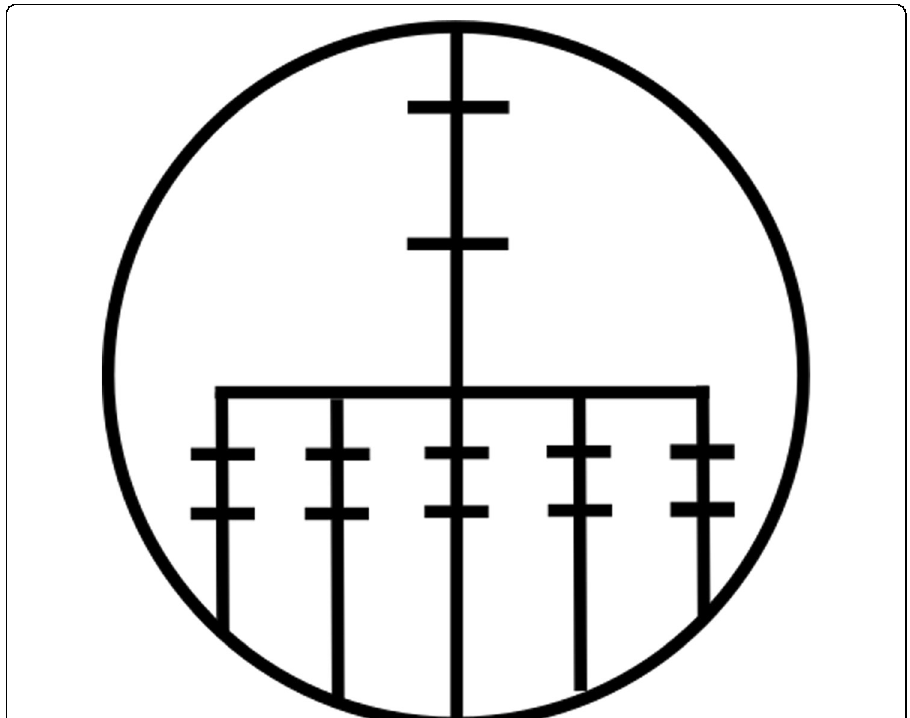
Fig. 8 Legend: The horizontal lines indicate access points, the vertical lines illustrate the linear access through EMMA